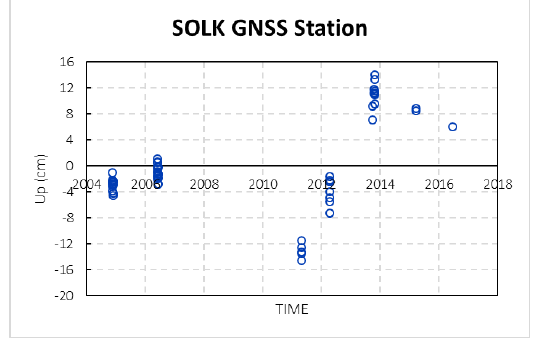
Figure 10. GNSS measurements from PHIVOLCS survey